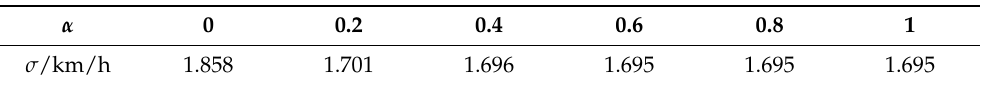
Figure 20. Comparing the speed of the motor with the compensable coefficient under different working conditions B. ( a ) α = 0; ( b ) α = 0.2; ( c ) α = 0.4; ( d ) α = 0.6; ( e ) α = 0.8; ( f ) α = 1. Table 6. The standard deviation of the vehicle speed corresponding to the compensable coefficient for different motors under working condition